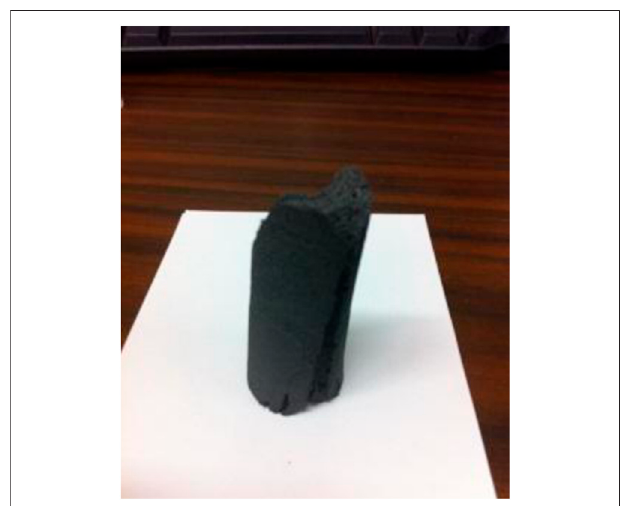
FIGURE2 | Picture ofthe sintered sampleafter the pureiron experiment (850 °